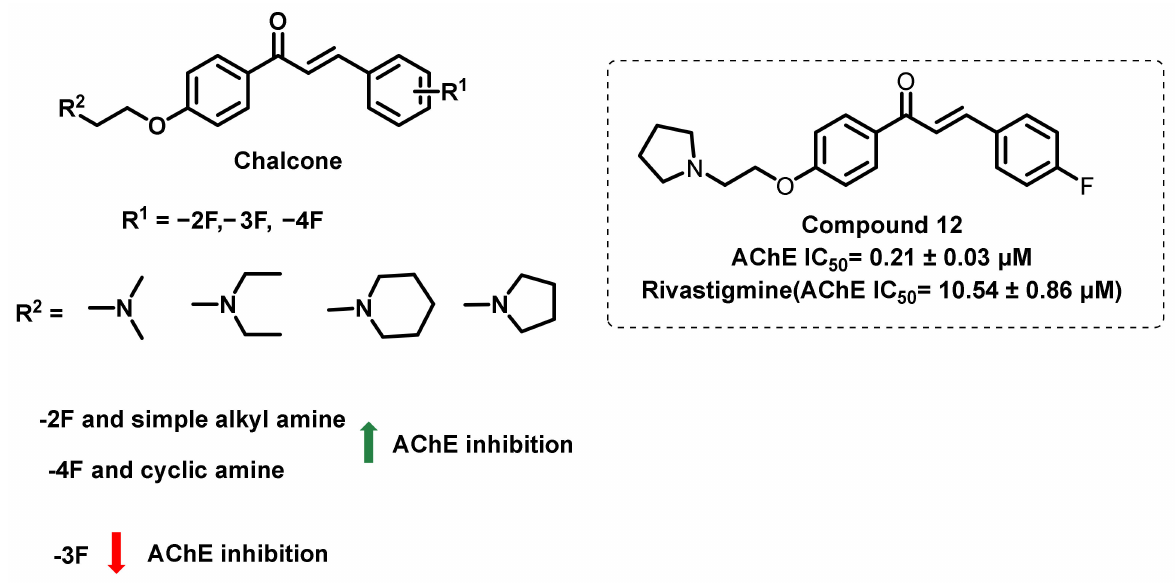
Figure 17. Fluoro-chalcone-substituted amino alkyl